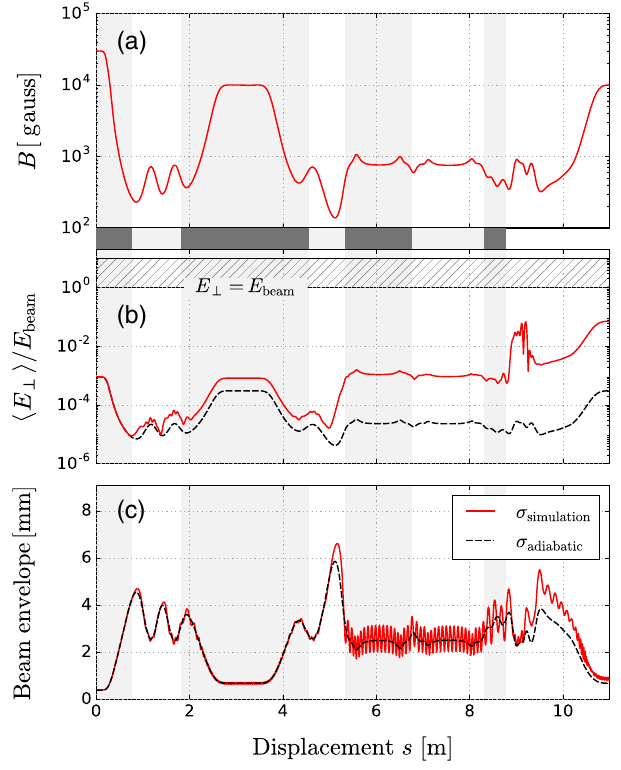
FIG. 9. Numerical simulation showing the properties of a 50-eV ¯ p bunch extracted from the CT to the ALPHA-g experiment, as a function of its longitudinal displacement s . (a) shows the magnetic field strength B while (b) shows the mean ¯ p transverse energy h E ⊥ i as a fraction of the beam energy E . (c) shows the beam simulated transverse beam envelope σ alongside Eq. (2), simulation which has been evaluated for the magnetic field shown in